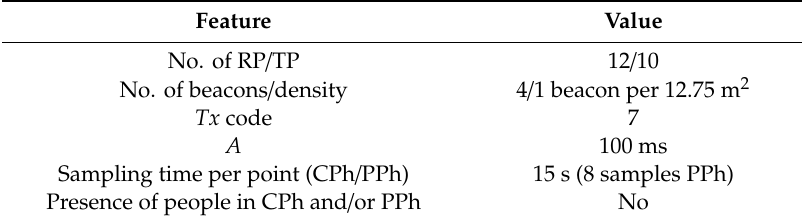
Table 10. Main features of Tests